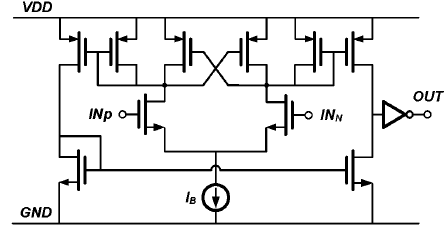
Figure 14. Schematic of the comparator, with cross coupled transistors as load for fast comparison.